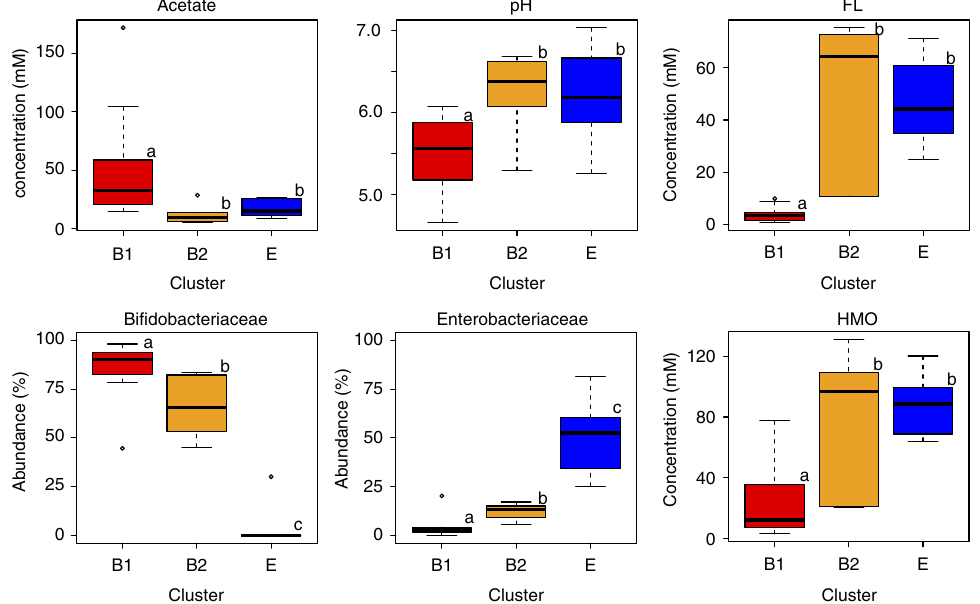
Figure 5 | Impact of FL-utilizing bifidobacteria on gut microbial ecosystems. Box plots showing differences among Bifidobacteria-dominant microbiota, with or without FL-utilizing bifidobacteria (clusters B1 and B2, respectively) and Enterobacteriaceae-dominant microbiota (cluster E). Different letters (a–c) above the boxes indicate significant differences between clusters ( P o 0.05, Mann–Whitney U -test with Bonferroni’s